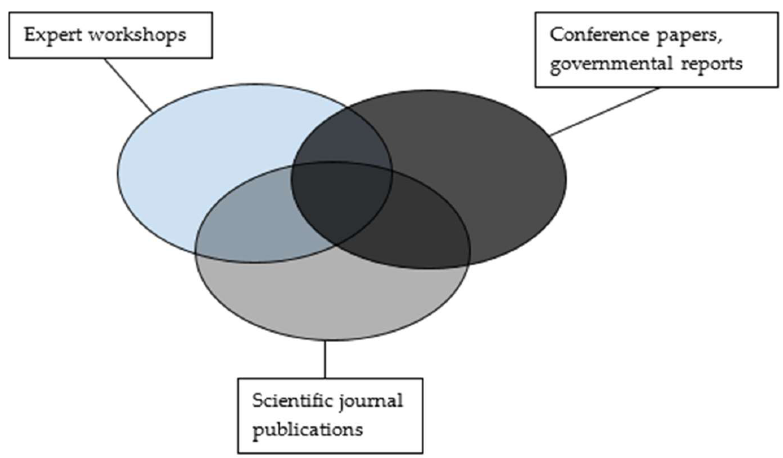
Figure 3. Methodological approaches on SMEs and energy policy programme design.